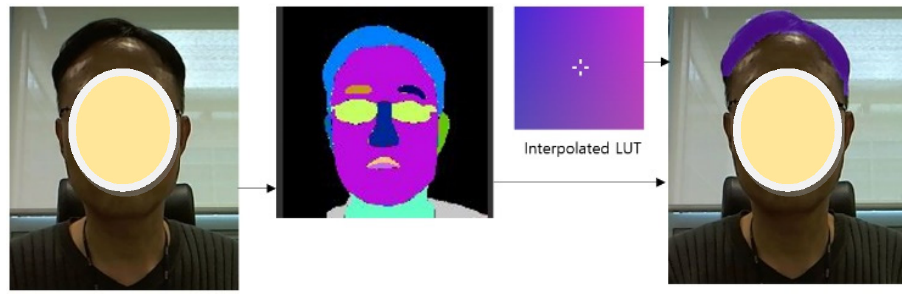
Figure 4. Hair recoloring process.